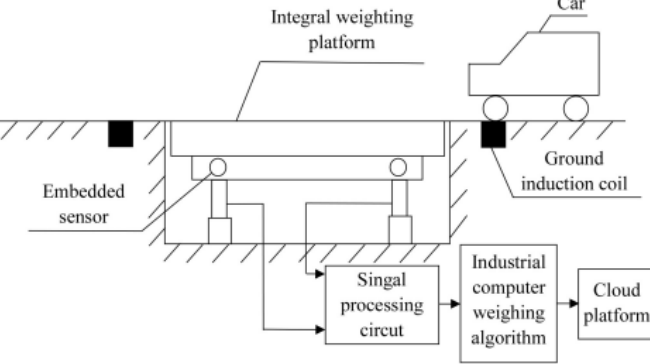
Figure 1. Structural diagram of a WIM system.